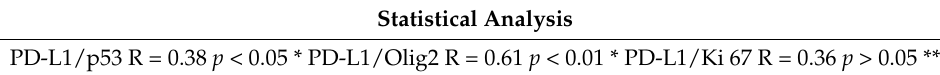
Table 5. Results of statistical analysis concerning PD-L1 correlations. Statistical